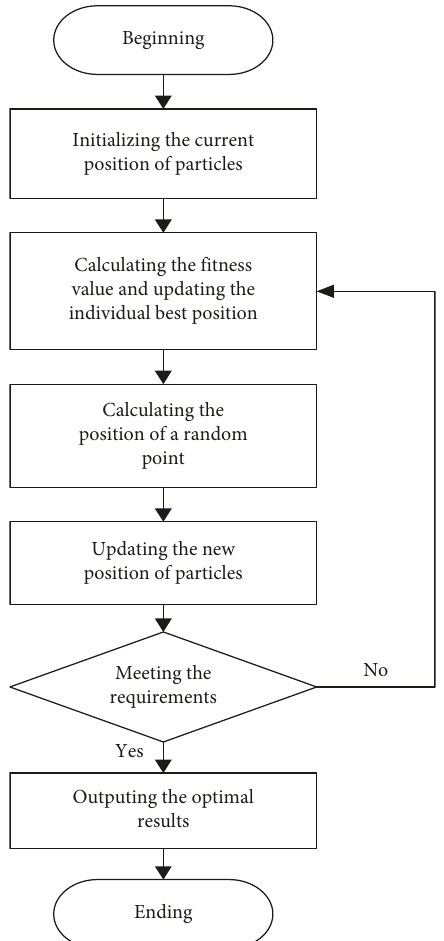
Figure 3: Process of the IQPSO